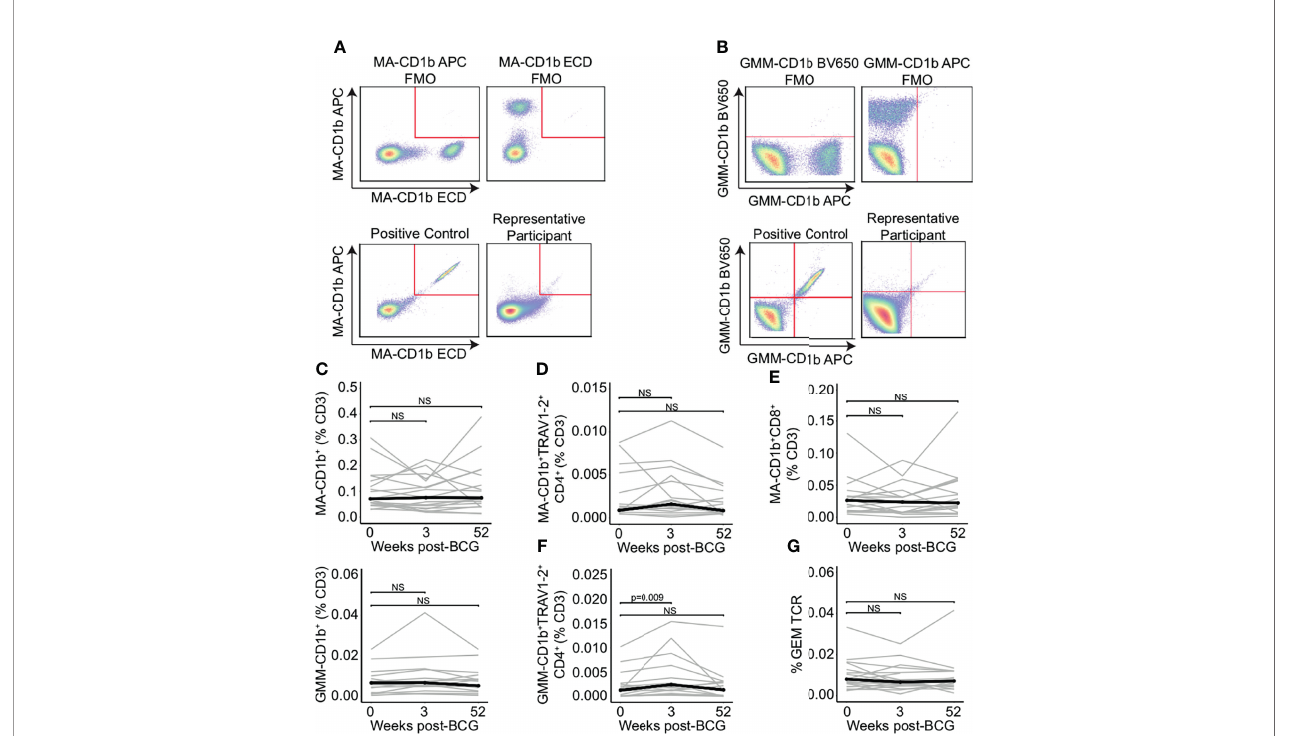
FIGURE 2 | Peripheral blood frequencies of mycolipid-speci fi c T cells are not modulated by BCG revaccination. CD1b tetramers loaded with mycolic acid (MA-CD1b) or glucose monomycolate (GMM-CD1b) were incorporated into a multi-parameter fl ow cytometry assay to measure changes in the frequency of mycolipid-speci fi c T cells following BCG revaccination. (A) The tetramer positive gate was de fi ned by a dual tetramer staining with electron coupled dye (ECD) and allophycocyanin (APC) and ‘ Fluorescence Minus One ’ (FMO) negative control (top) and a positive control using MA-speci fi c T cell line diluted in donor PBMC (bottom left). Representative MA-CD1b tetramer staining from one participant is shown (bottom right). (B) The GMM-CD1b tetramer positive gate was de fi ned by a dual tetramer staining with Brilliant Violet 650 (BV650) and allophycocyanin (APC) and ‘ Fluorescence Minus One ’ (FMO) negative control (top) and a positive control using GMM-speci fi c T cell line diluted in donor PBMC (bottom left). Representative GMM-CD1b tetramer staining from one participant is shown (bottom right). (C) Percentage of MA-CD1b and GMM-CD1b tetramer positive T cells, (D) MA-CD1b tetramer positive, TRAV1-2 positive, and CD4 positive, and (E) MA-CD1b tetramer positive and CD8 positive T cells were quanti fi ed. Percentages are expressed as a percent of CD3 positive cells and connected lines depict the percentage of MA-CD1b tetramer positive cells from each participant at each time point (grey). The median percentage from each time point is shown (black) (F) Percentage of GMM-CD1b tetramer positive, TRAV1-2 positive, and CD4 positive T cells were quanti fi ed. Percentages are expressed as a percent of CD3 positive cells in each sample. (G) Percent of GEM templates that contain TRAV1-2, TRAJ9-1, and have a CDR3 length of 13 amino acids, expressed as a percent of total productive templates at each time point. Statistical testing was performed using the Wilcoxon signed-rank test with Benjamini-Hochberg correction for multiple hypothesis testing, and adjusted p-values are shown. NS, Not Signi fi